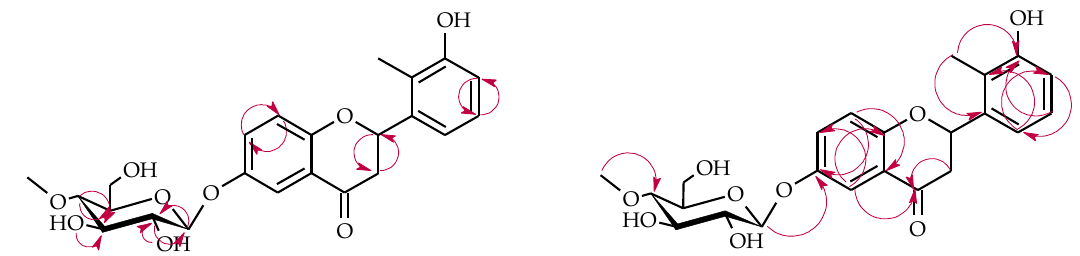
Int. J. Mol. Sci. 2021 , 22 , x FOR PEER REVIEW Scheme 4. Key COSY (on the left) and HMBC (on the right) correlations for the structure elucidation of product 4b .